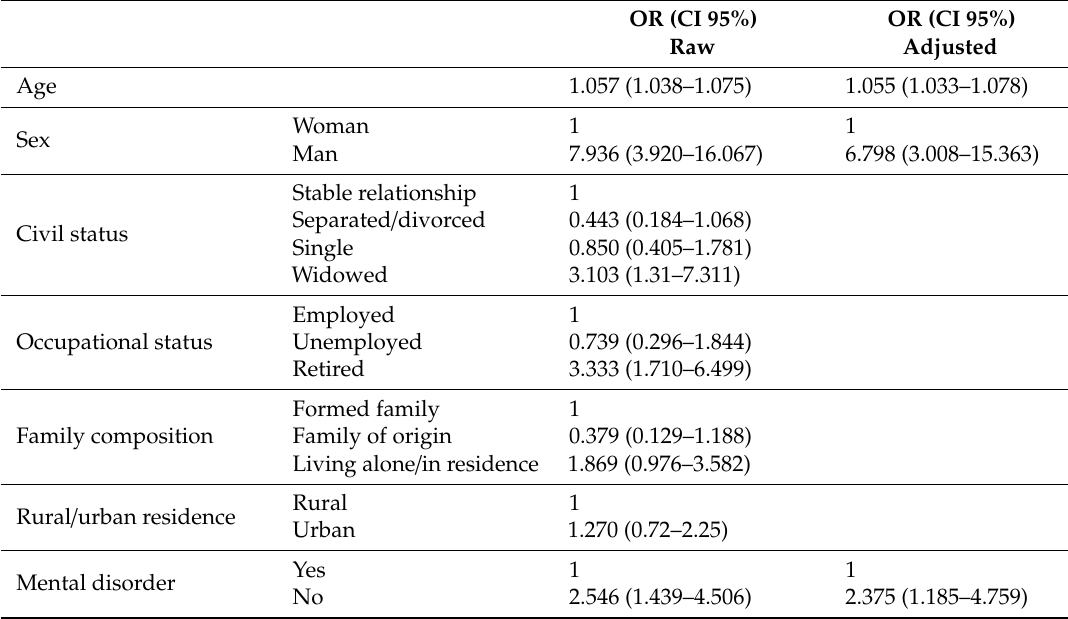
Table 5. Raw and adjusted odds ratio (OR) values for factors associated with completed